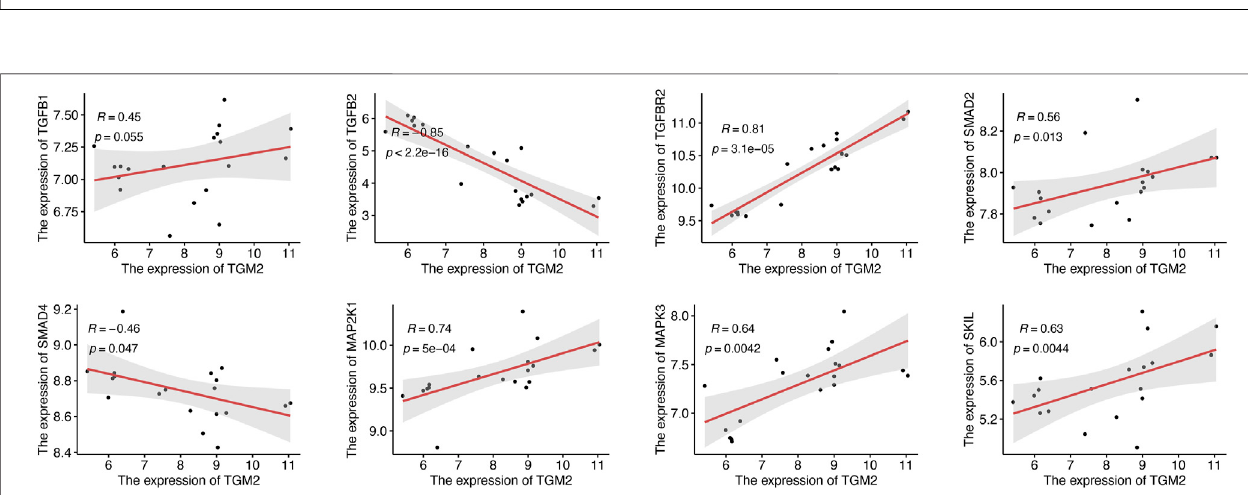
FIGURE 5 | Correlation analysis of TGM2 and keloid-associated genes. Radar plots summarized the genes associated with TGM2 in the gene sets of collagen formation, epithelial mesenchymal transition, hypoxia and extracellular matrix formation. Correlation coef fi cients between TGM2 and keloid-associated genes were indicatedinblue.Scatterplotsdemonstratedsigni fi cantpositivecorrelationsbetweenTGM2andinterleukin6(IL6),hypoxiainduciblefactor1subunitalpha(HIF1A),and fi bronectin 1 (FN1).